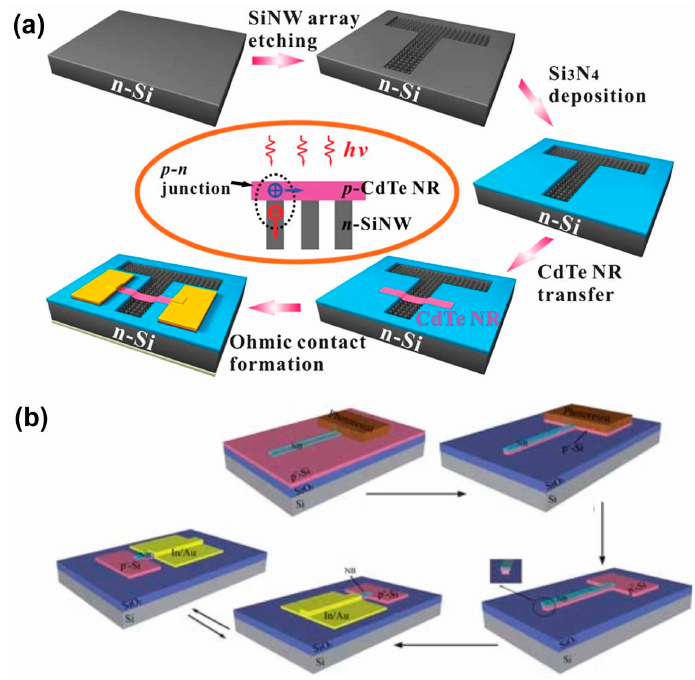
Figure 9. ( a ) Schematic illustration of the fabrication process for the p-CdTeNR/n-SiNW array heterojunction device. Reproduced with permission from [53], Copyright 2012, The Royal Society of Chemistry. ( b ) Flowchart for the fabrication process of the n-CdS X Se 1 − X /p + -Si parallel-nanobelt heterojunctions: (1) The NB suspension was dropped onto the SOI substrate and photoresist pads (200 mm long, 50 mm wide) were patterned by UV lithography. (2) The Si was etched by ICP etching. The photoresist together with the nanobelts were used as the mask. (3) The photoresist was removed. The cross-section at the end of the nanobelts was magnified to show the undercut effect. (4) The final device from two angles of view after the In/Au (10 nm/100 nm) ohmic contact electrode was made. Reproduced with permission from [54], Copyright 2010, The Royal Society of Chemistry.